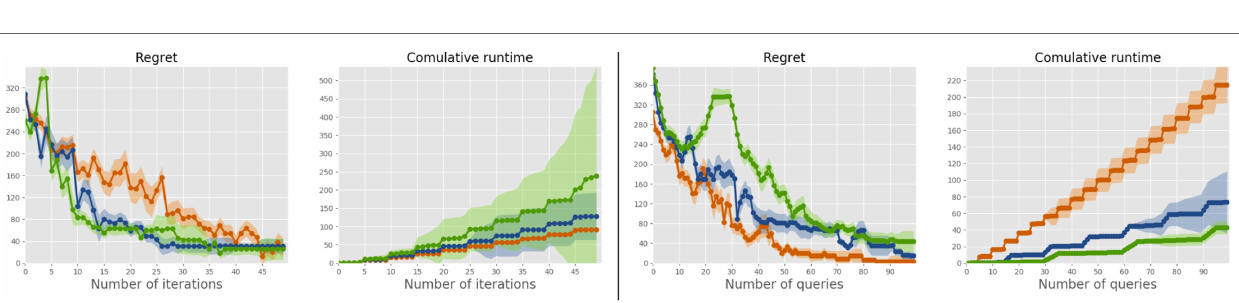
FIGURE 4 | Results for SM for K = 2 (red), K = 3 (blue), and K = 4 (green) on the PC dataset for the sparse uniform distribution. Regret and time are plotted against number of iterations (left) and number of acquired constraints